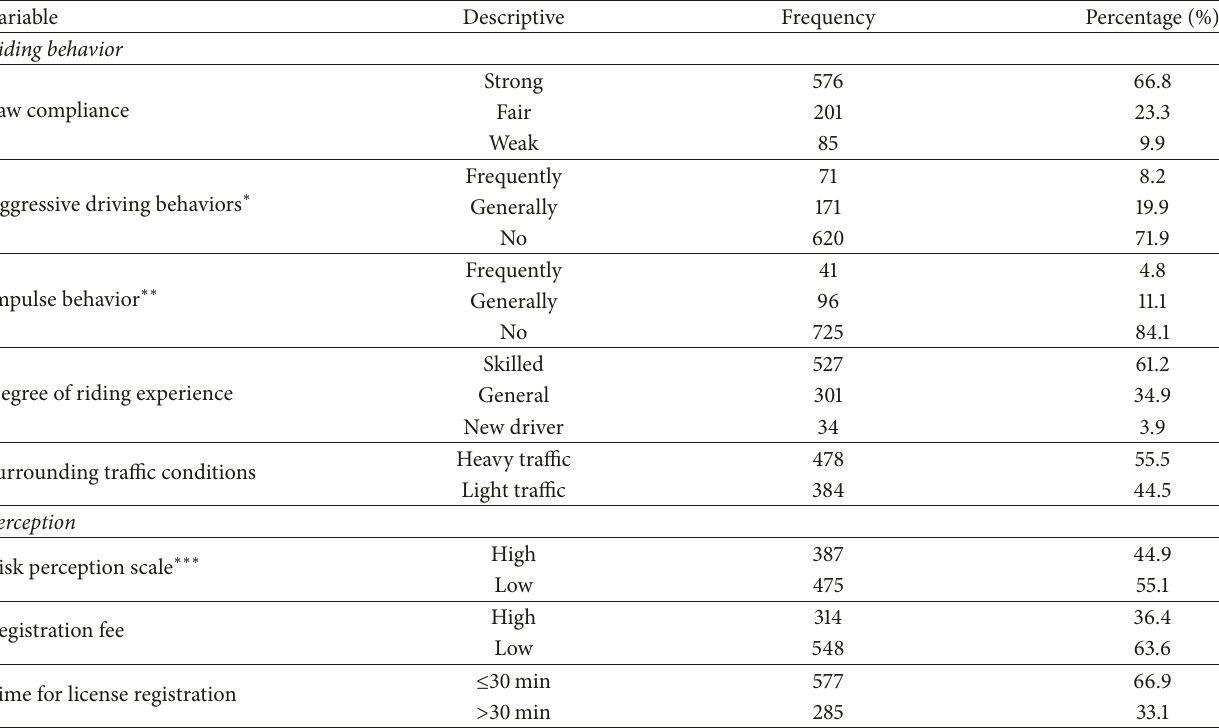
Table 4: Descriptive statistics for riding behavior and